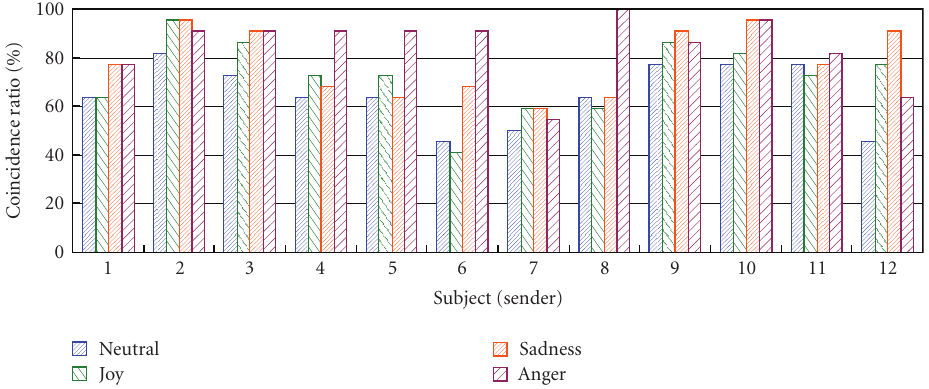
Figure 23: Coincidence ratio of emotion as a function of emotions and subject (sender).